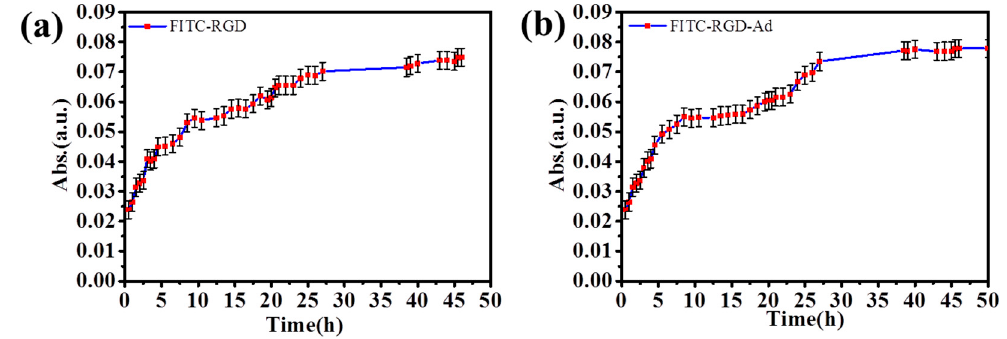
Figure 7. The release plots of ( a ) FITC–RGD and ( b ) FITC–RGD–Ad from (PAH/SiO 2 ) 1 /(PAH/HA–CD) 30 /(PAH/SiO 2 ) 1 /(PAH/HA–CD) 30 laminated multilayer